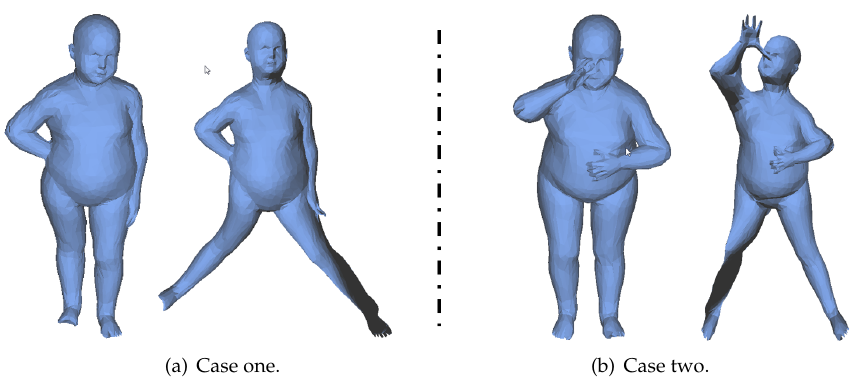
Figure 10. Failure cases. Left: the original mesh. Right: the unfold mesh. Our algorithm unfolds the legs successfully, but the adhesion remains